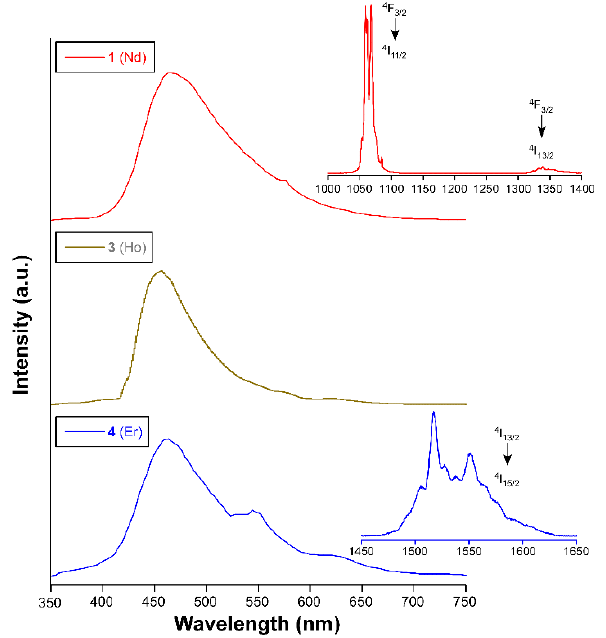
Figure 8. Emission spectra of compounds 1 , 3 , and 4 recorded at low temperature. The insets aside spectra of 1 and 4 correspond to the emissions observed in the near-infrared (NIR) spectra.